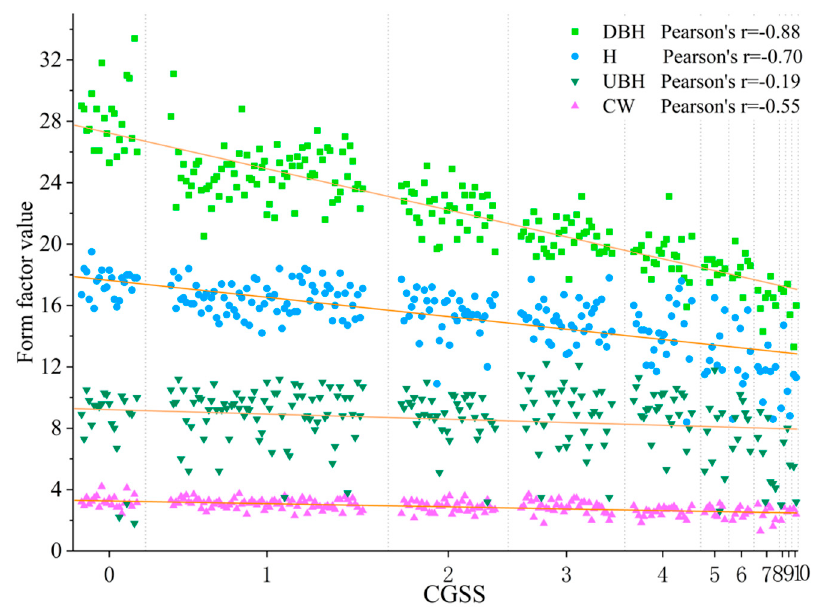
Figure 7. Distribution map of morphological structure factor values of Chinese fir of the same forest age under different comprehensive grades of spatial structure.